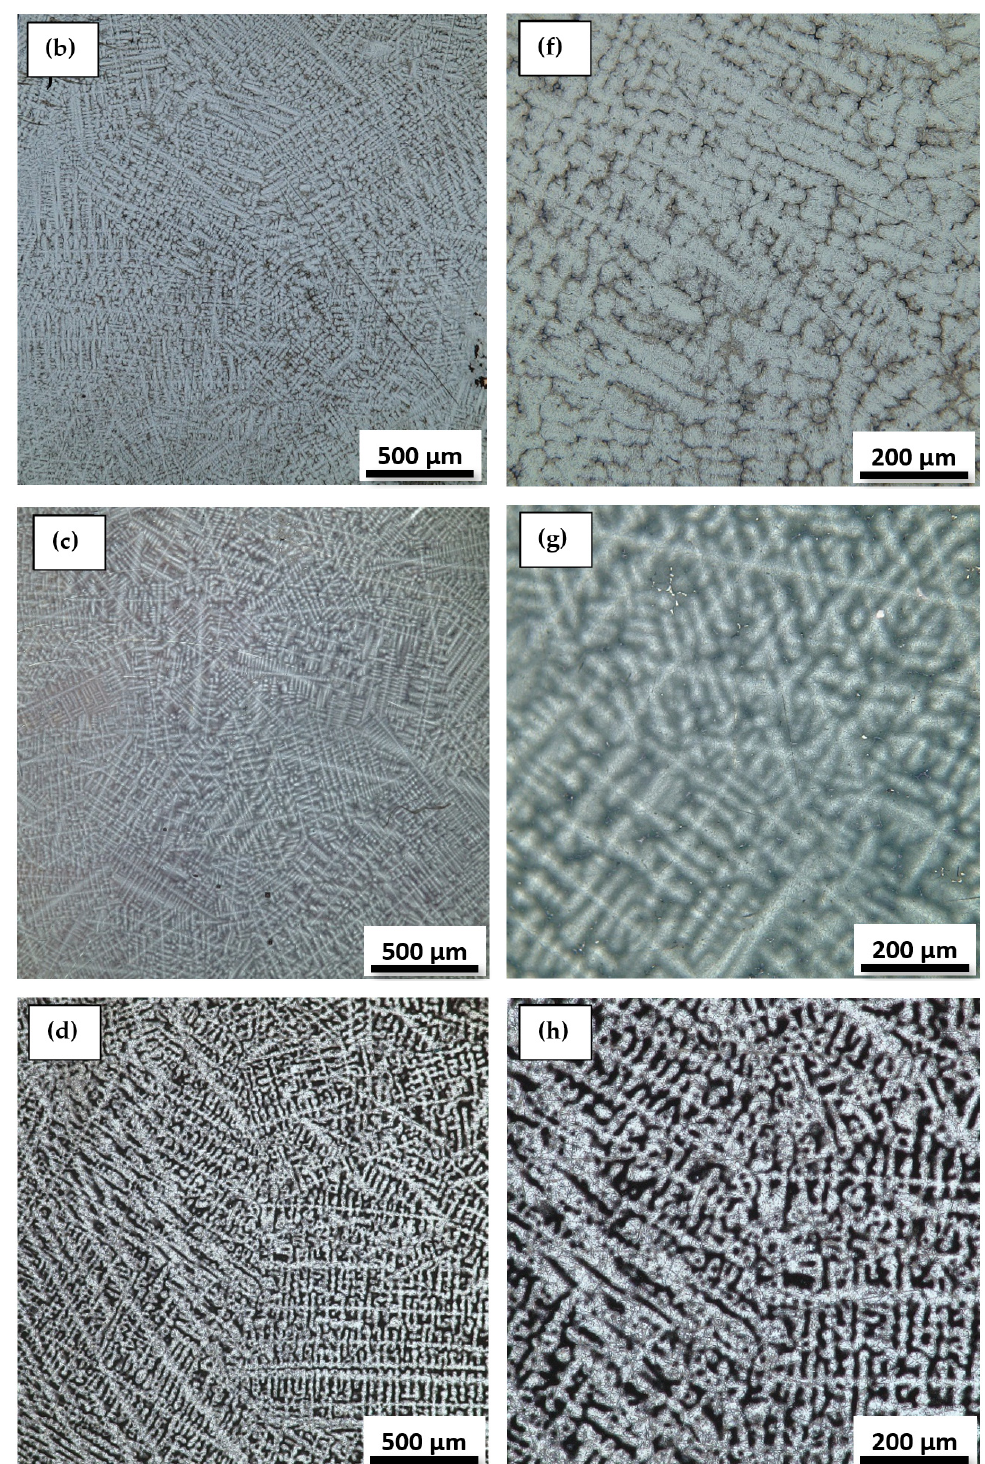
Figure 5. Microstructure analysis of Ti15Mo7Zr15Ta alloys with different percentage of Si added at a magnifying power of 70x: ( a ) Ti15Mo7Zr15Ta, ( b ) Ti15Mo7Zr15Ta0.5Si, ( c ) Ti15Mo7Zr15Ta0.75Si, ( d ) Ti15Mo7Zr15Ta1Si and of 280x: ( e ) Ti15Mo7Zr15Ta, ( f ) Ti15Mo7Zr15Ta0.5Si, ( g ) Ti15Mo7Zr15Ta0.75Si, ( h ) Ti15Mo7Zr15Ta1Si.